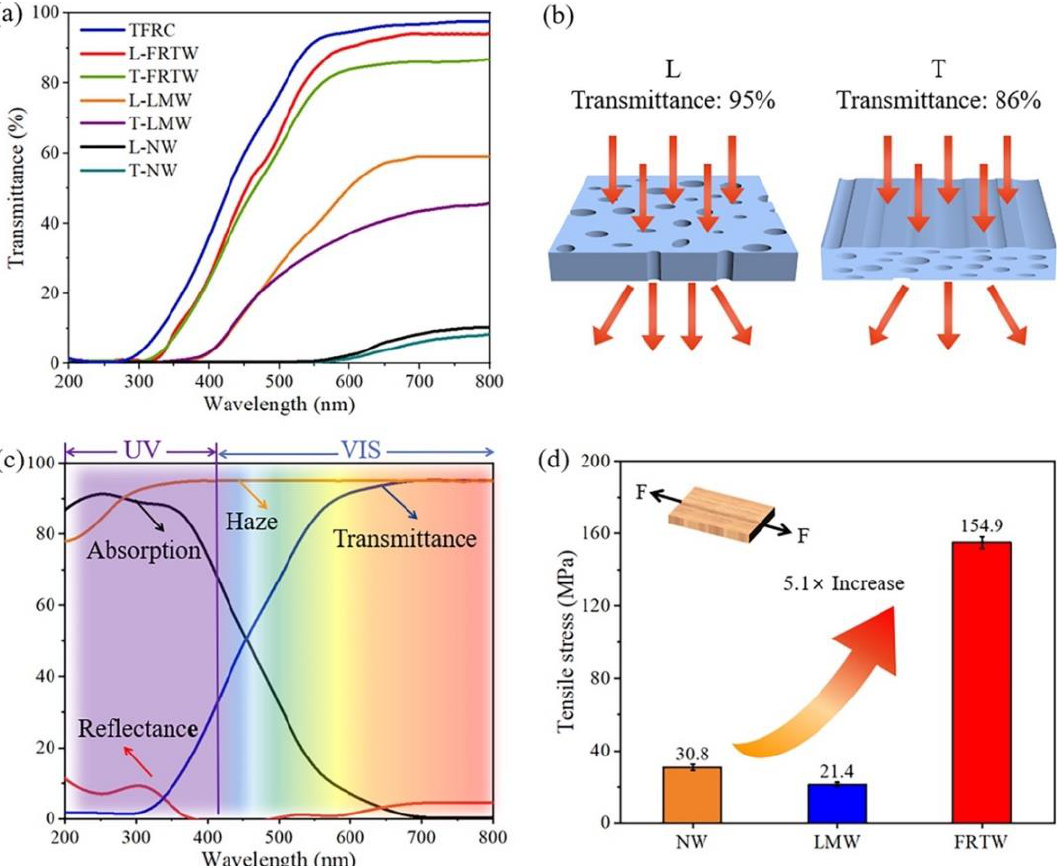
Figure 35. Optical and mechanical properties of wood samples. ( a ) The optical transmittance of natural (pristine) wood (NW), lignin-modified wood (LMW), flame-retardant transparent wood (FRTW), and transparent flame-retardant cured resin system (TFRC). ( b ) Schematic illustration of light propagation through the FRTW in the L (parallel to the wood growth direction) and T (perpendicular to the wood growth direction) modes. ( c ) Absorption, haze, reflectance, and transmittance of L-FRTW. ( d ) Tensile stress of the NW, LMW, and FRTW samples. Reprinted with permission from [49], copyright 2022, John Wiley & Sons.